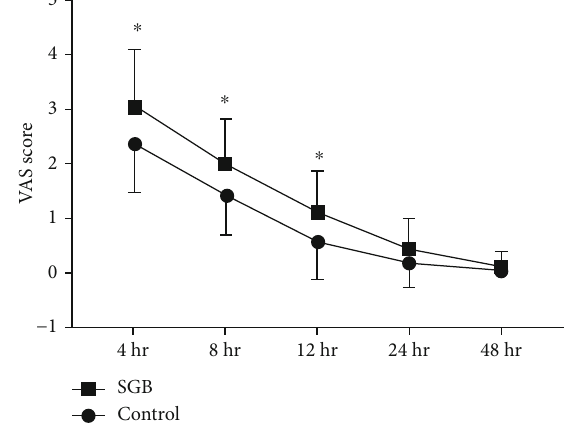
Figure 3: VAS pain scores at the di ff erent time points. Time interval is de fi ned as time between baseline and postoperative time. VAS: visual analog scale; SGB: stellate ganglion block. Data are expressed as mean ± SD . ∗ P < 0 : 05 compared with the PNB only